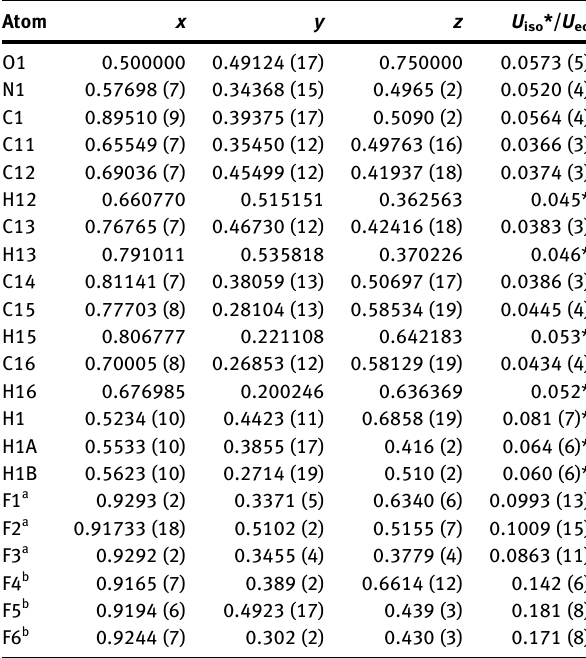
Table  : Fractional atomic coordinates and isotropic or equivalent isotropic displacement parameters (Å 